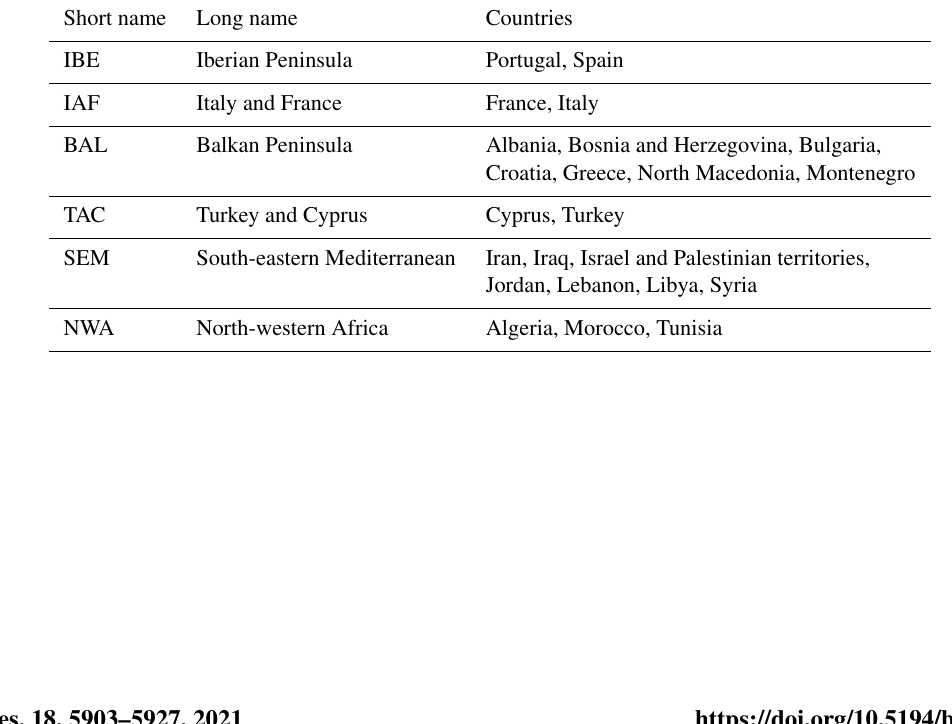
Table B2. Overview of the six subregions and the corresponding countries used in this